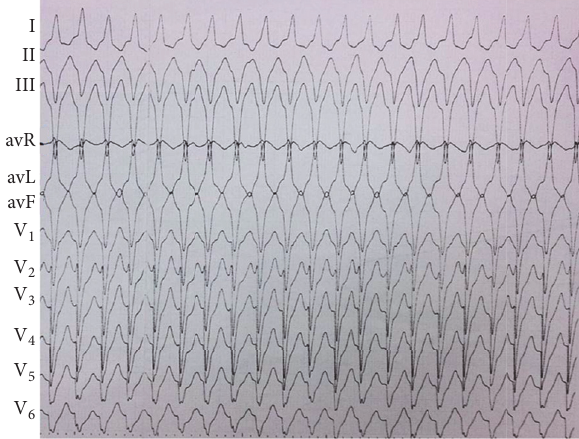
Figure 1: Twelve-lead ECG of IVT.